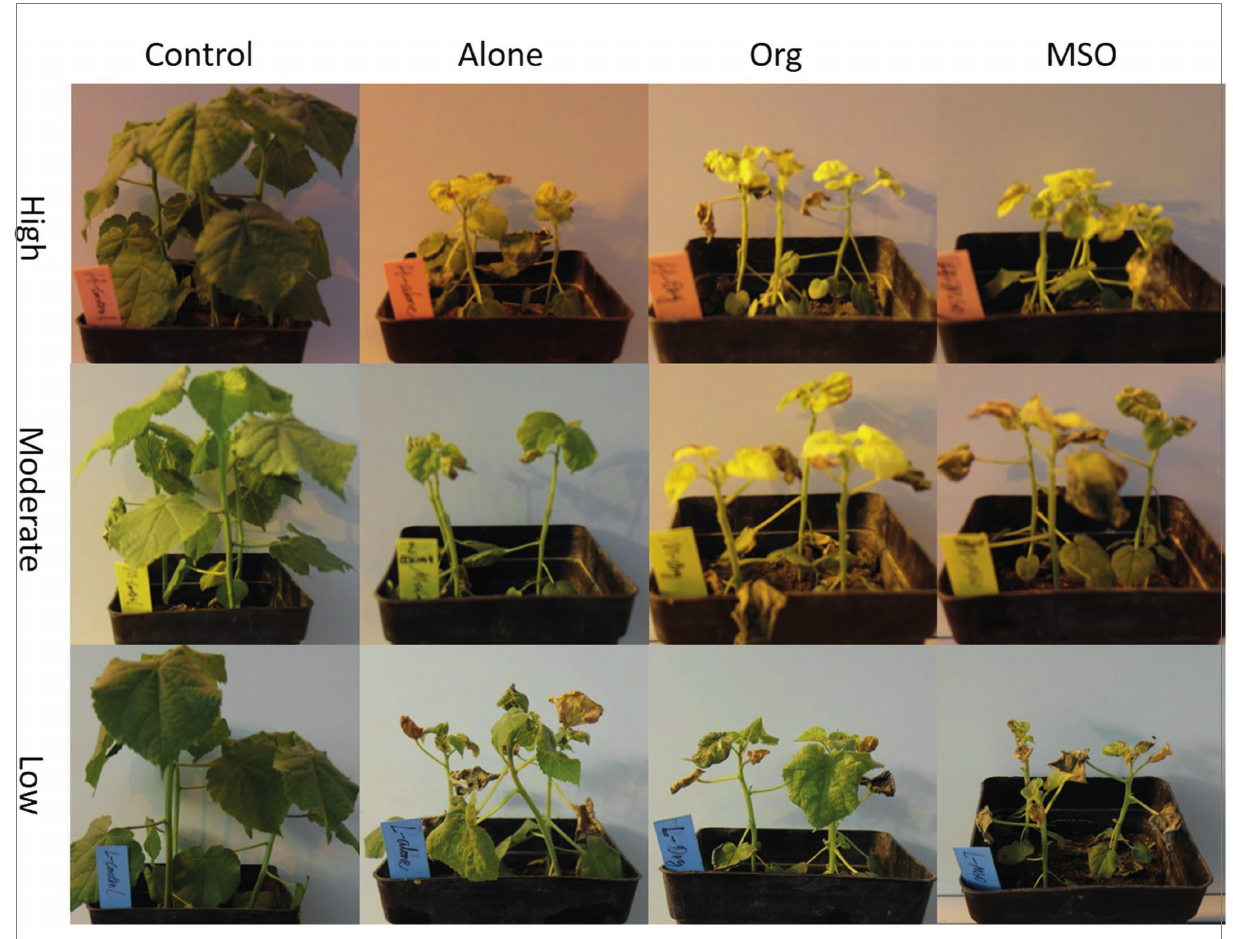
FIGURE 4 Images of velvetleaf taken at 3 weeks after application. The topramezone dose was 6.3 g a.i. ha − 1 ; control means treated with tap water; Alone means topramezone was applied alone; Org means topramezone was applied together with organosilicone; MSO means topramezone was applied together with